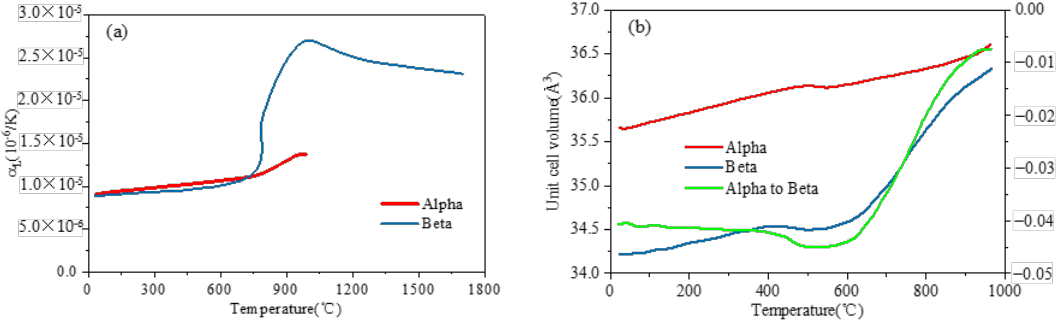
Figure 7. ( a ) Linear coefficient of thermal expansion; ( b ) unit cell volume for each phase, and transformation-induced volumetric strains as a function of temperature [5].